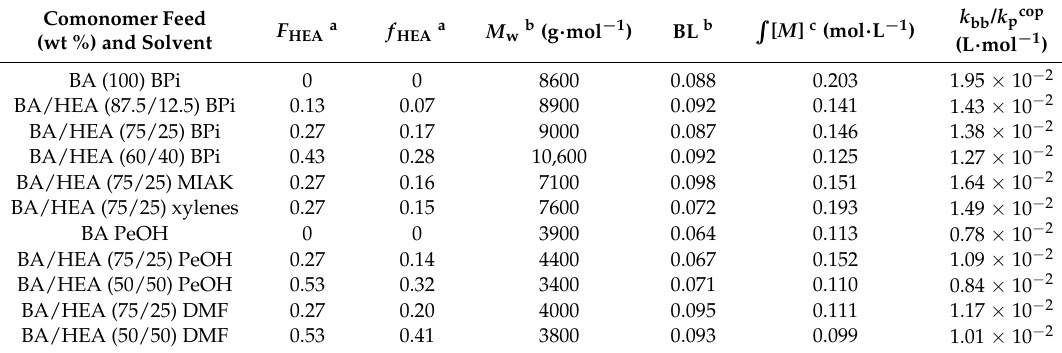
Table 3. Copolymer compositions, polymer properties, and estimated backbiting rate coefficients ratioed to propagation ( k bb / k pcop ) from BA/HEA semi-batch copolymerizations conducted in various solvents at 138 ◦